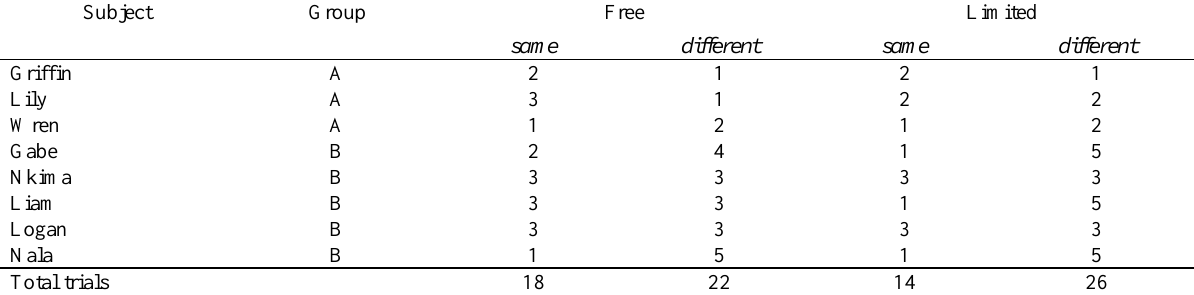
Focal Subjects’ Choices of the Same or Different Object as the Model Subjects in each Condition in Study